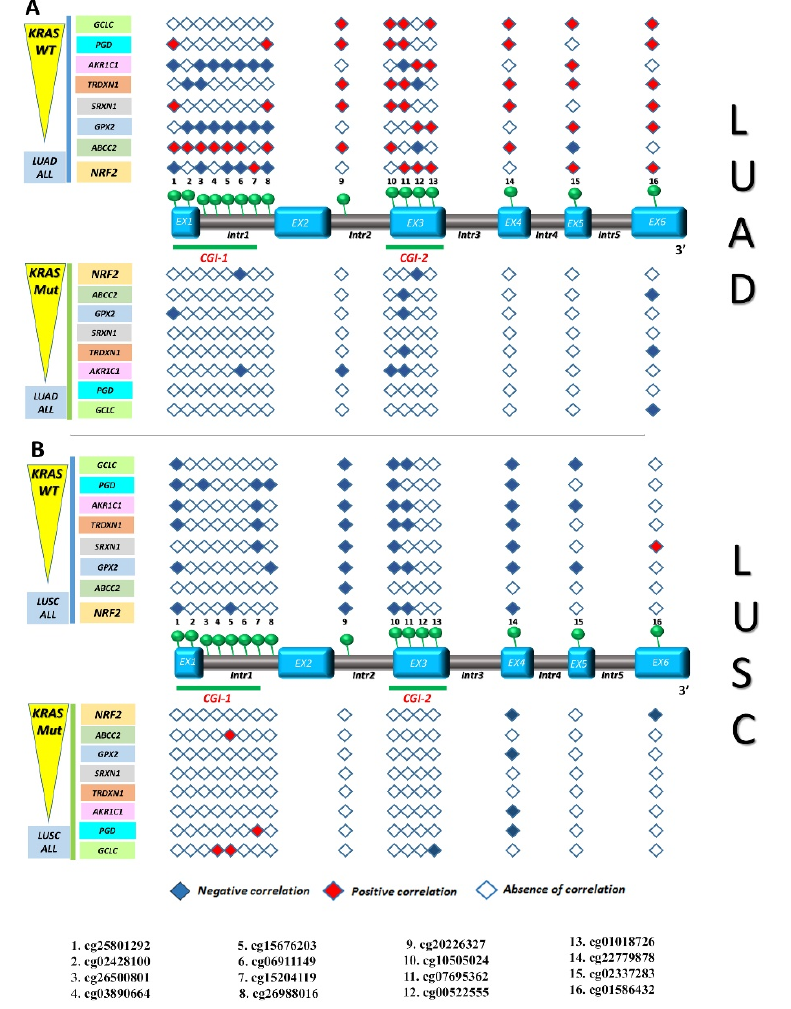
Figure 9. Correlation between KEAP1 CpGs methylation and transcript levels of NRF2 or its target genes in LUAD and LUSC KRAS wild-type/KRAS mutated subpopulations. The KEAP1 gene structure, is shown in the middle, including exons (sky blue boxes) and introns (brown boxes), as well as two CpG islands: CGI-1 and CGI-2 (both underlined with green bars). A total of 16 CpG sites, marked with green circles, are indicated from 5 ′ to 3 ′ genomic localization (listed below). A filled rhombus, corresponding to a KEAP1 CpG site, depicts a significant inverse (blue square) or direct (red square) correlation ( R ≤ –0.1; p < 0.05) between methylation and transcript levels of NRF2 or its target